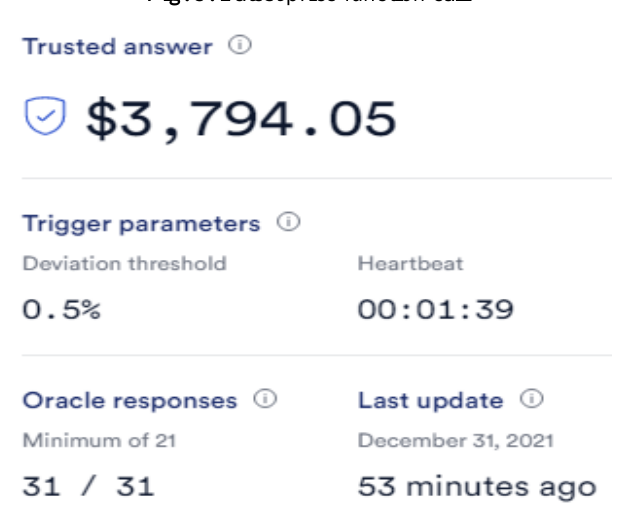
Fig. 4. Aggregated price of ETH/USD